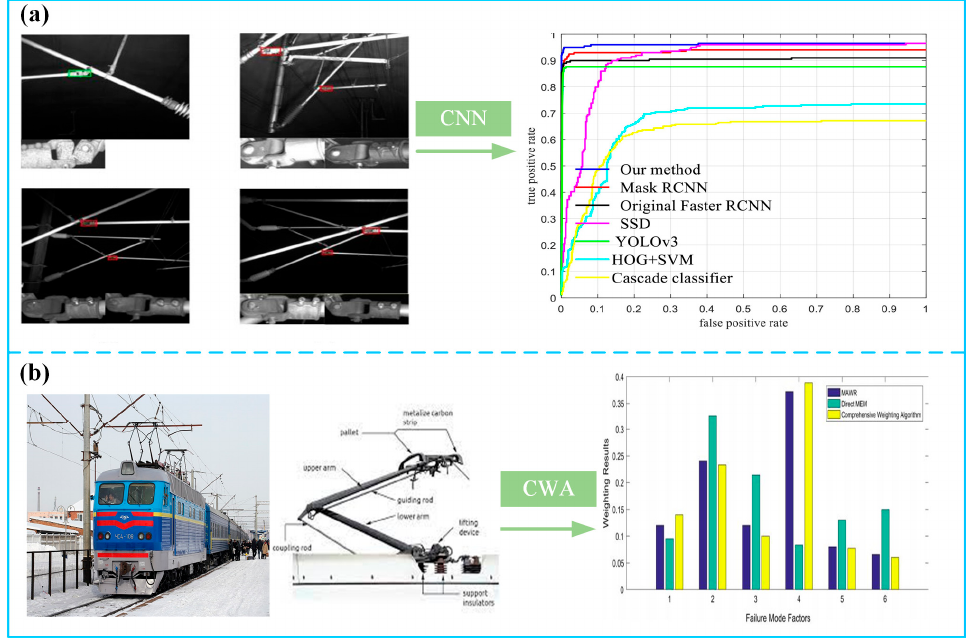
Figure 9. Fault diagnosis method of electrical system: ( a ) convolutional neural network (CNN) [90]; ( b ) comprehensive weighting algorithm (CWA) [91].